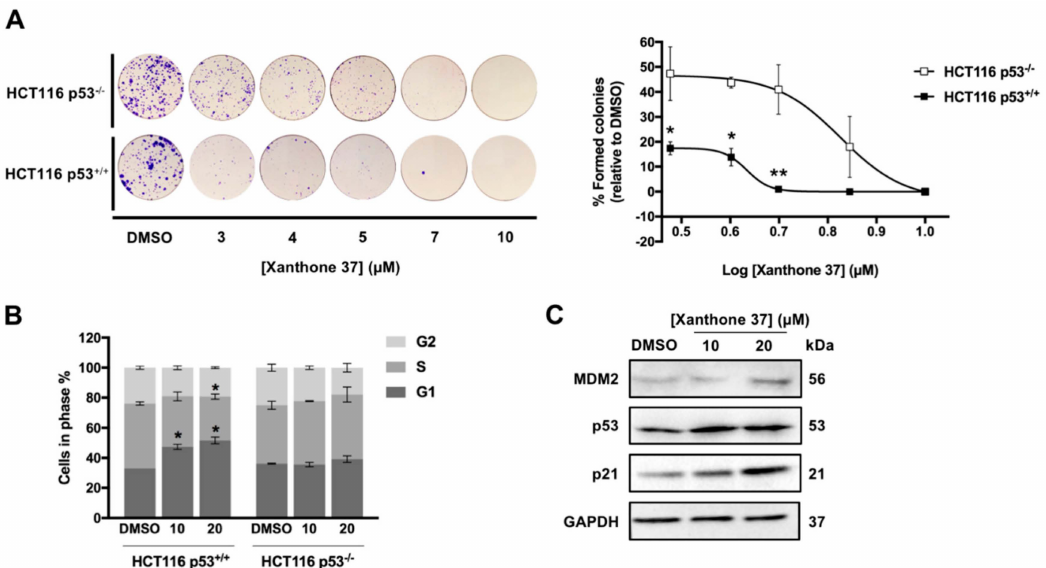
Figure 4. Xanthone 37 inhibits the colony forming capability of HCT116 cells through induction of cell cycle arrest and in a p53-dependent manner. ( A ) Evaluation of colony forming ability in HCT116 p53 +/+ and HCT116 p53 − / − colon cancer cells after 11 days treatment with 3-10 µ M of xanthone 37 ; results were plotted setting as 100% the colonies formed after treatment with dimethyl sulfoxide (DMSO). ( B ) E ff ect of 10 and 20 µ M of xanthone 37 on cell cycle progression of HCT116 p53 +/+ and HCT116 p53 − / − cells, after 24 h treatment. ( C ) E ff ect of 10 and 20 µ M of xanthone 37 on the expression levels of MDM2, p53, and p21 in HCT116 p53 +/+ cells analyzed by Western Blot after 24 h treatment. Immunoblots represent one of three independent experiments; Glyceraldehyde 3-phosphate dehydrogenase (GAPDH) was used as loading control. ( A , B ) Data are mean ± SEM of three independent experiments; values significantly di ff erent from HCT116 p53 − / − cells using two-way ANOVA with Sidak’s multiple comparisons test ( A ) or DMSO using Student’s t -test ( B ) are indicated: * p < 0.05; ** p <